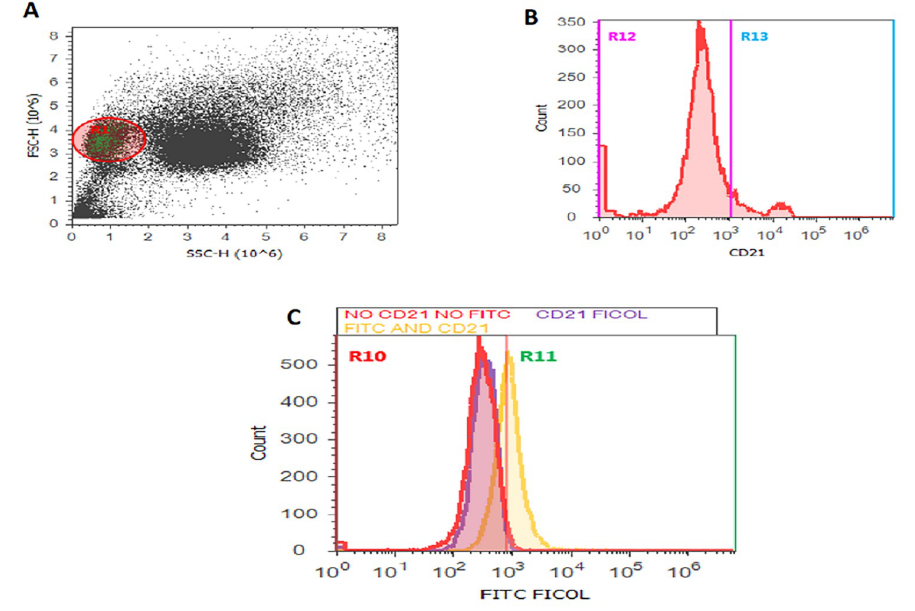
Fig 6. Binding of biotinlylated prSbi to canine B cells measured using flow cytometry. (A) The lymphocyte population was identified using forward and side scatter. (B) B cells labeled with anti-CD21 (Region R13) were selected for analysis of prSbi binding. (C) Binding of biotinylated prSbi with B cells was measured by the detection of FITC- avidin conjugate in region R11 (yellow peak) and compared with negative controls consisting of PE anti-CD21 and FITC-avidin without biotin (red peak) and PE anti-CD21 alone (violet peak).